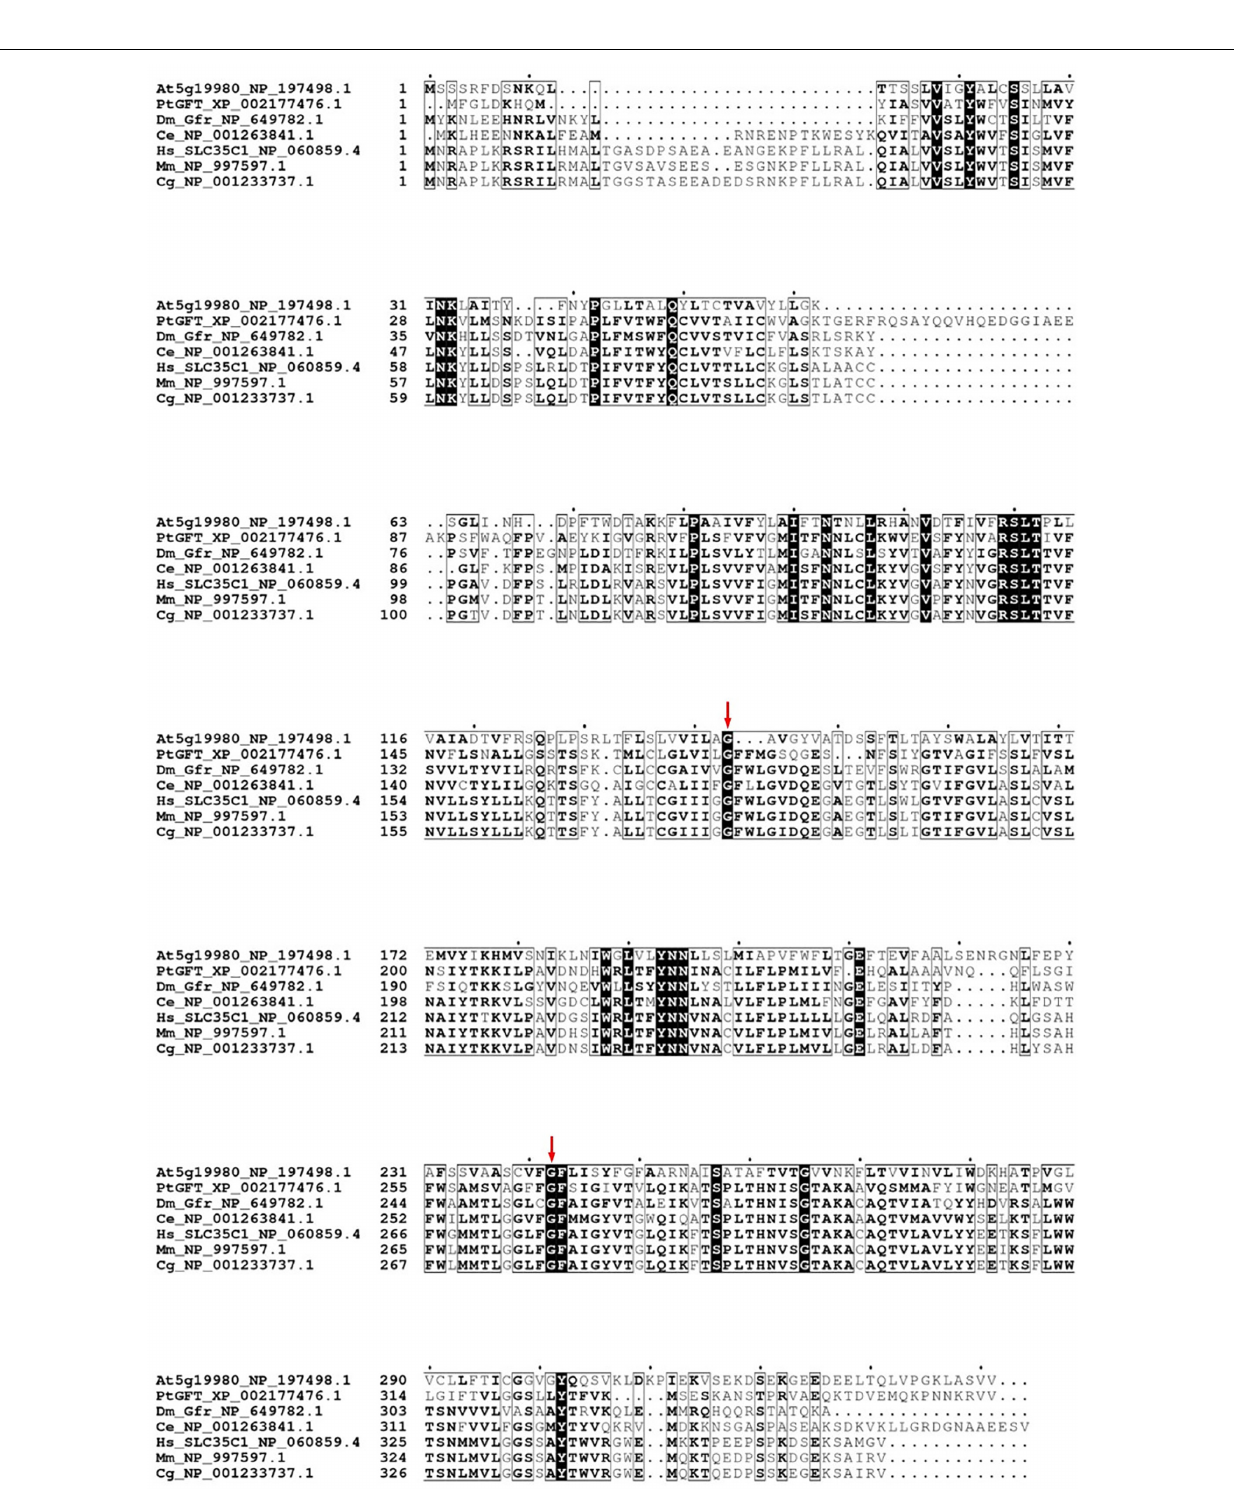
Frontiers in Plant Science |